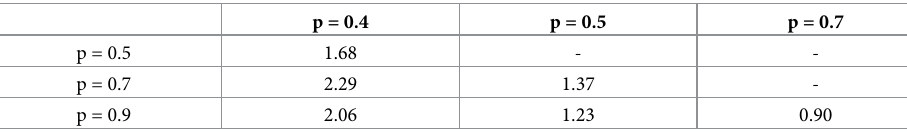
Table 5. Odds ratios among the four different